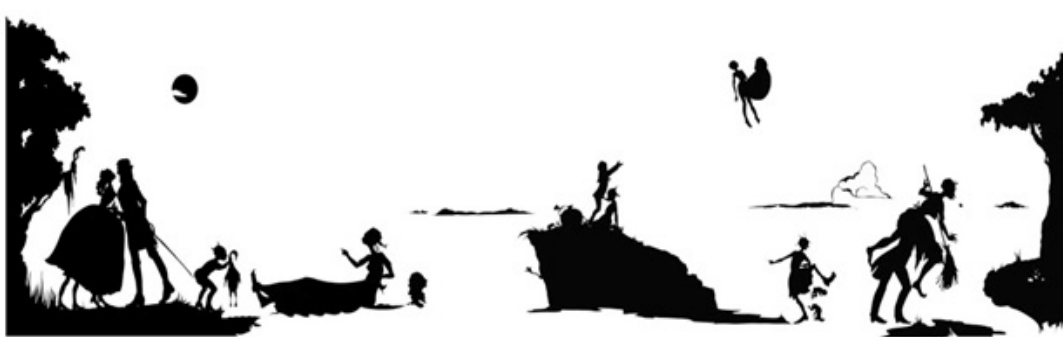
Figure 1 . Kara Walker, Gone, An Historical Romance of a Civil War as It Occurred Between the Dusky Thighs of One Young Negress and Her Heart (1994). Cut paper on wall; 13 x 50 ft. (4 x 15.2 m). © Sikkema Jenkins & Co. To be sure, Walker’s Gone mocks the solemnities and pretensions of the old south in a darkly comic way that some black spectators may find objectionable, but Walker is very serious about the subject matter. Part of the dual critique of Walker’s black camp is that she tweaks the pretensions of the politics of black respectability as much as she ridicules the pomposity of white supremacist logics both subtle and thuddingly